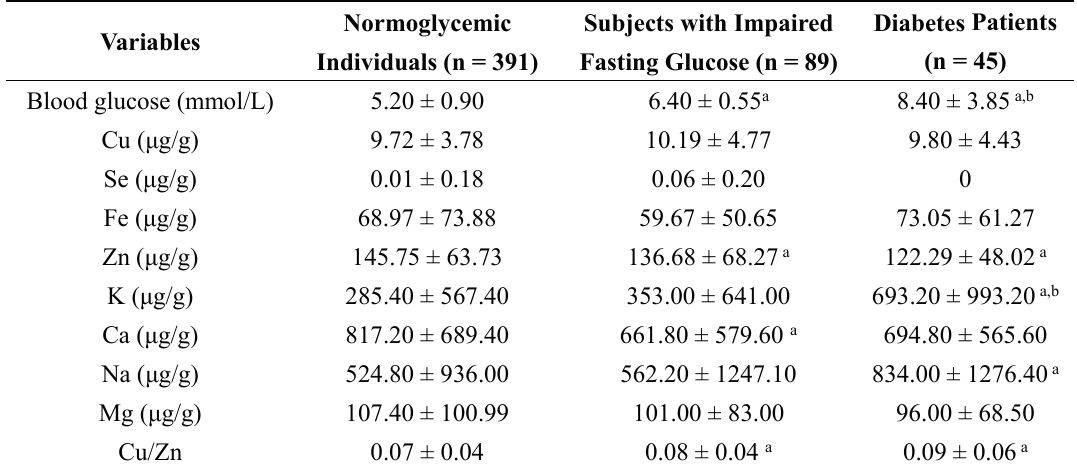
Table 3. Comparison of hair element contents and blood glucose levels among normoglycemic, IFG, and DM subjects.